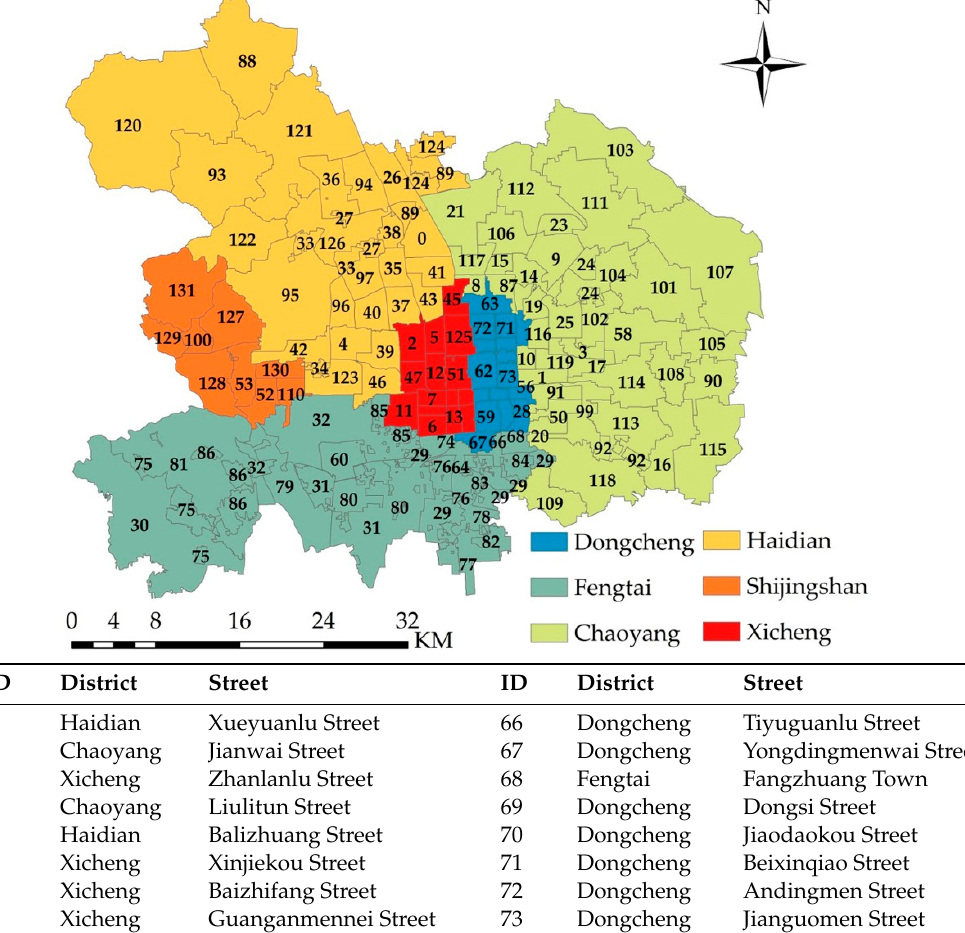
Table A1. The administrative division table of Beijing corresponds to detailed